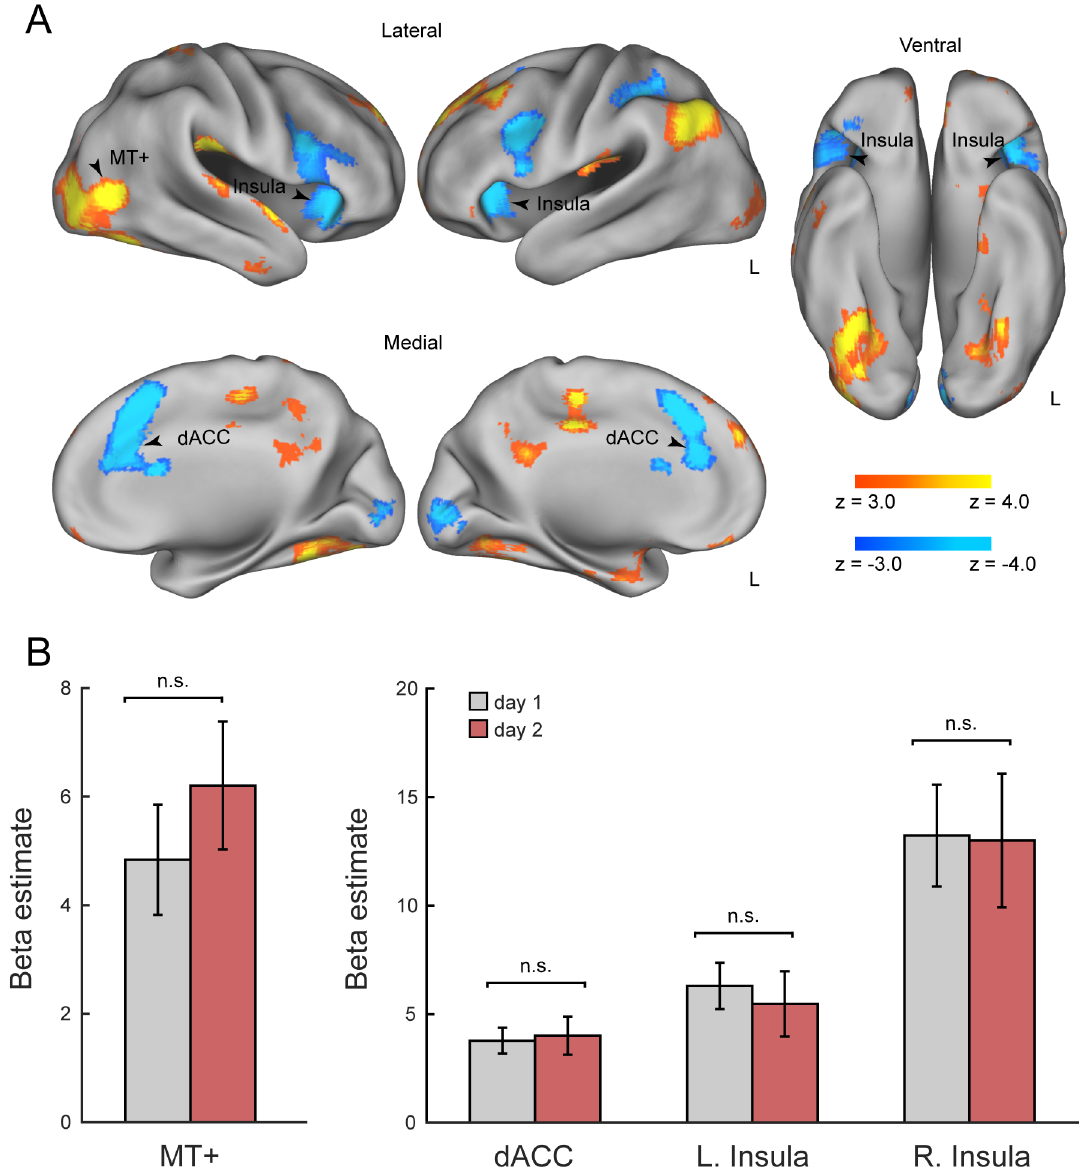
Fig 2. Task-related fMRI activation. (A) Positive and negative parametric effects of motion coherence. The statistical maps indicate brain regions showing significant activation increases with the coherence level (hot, including the MT+) and decreases with the coherence level (cold, including the dACC and bilateral insula). All maps are thresholded at P < 0.05, cluster-level FWE corrected across the whole brain. (B) Mean beta values for regions MT+, dACC, left and right insula. Peak coordinates derived from combining day 1 and day 2 t-fMRI data (Table 1). dACC: dorsal anterior cingulate